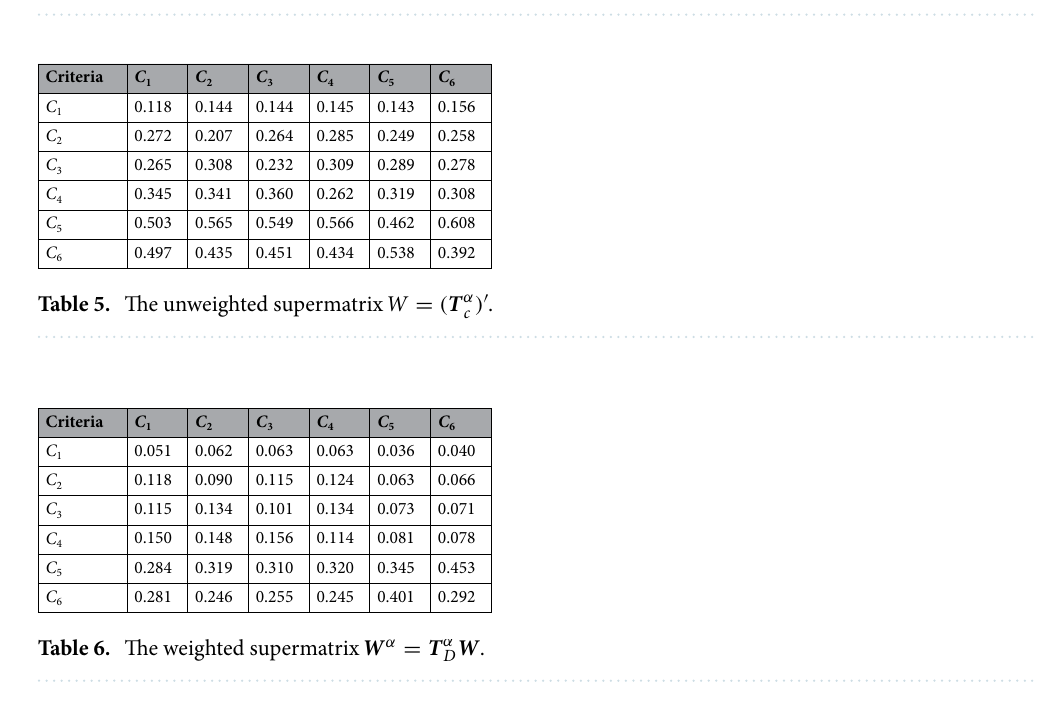
Figure 1. The INRM of influential relationships within biometrics.